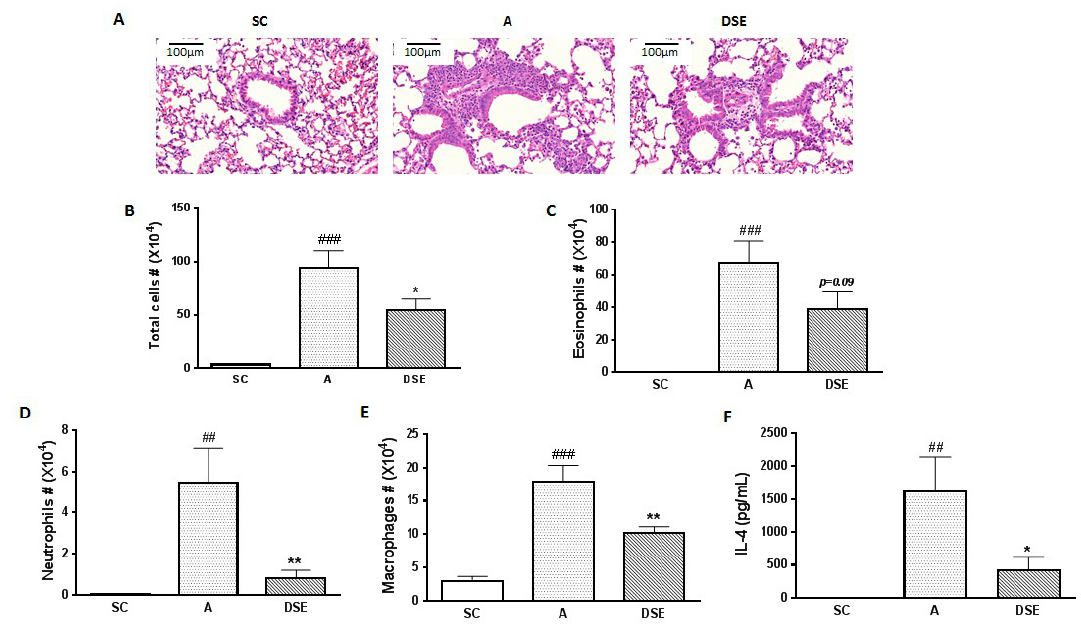
Figure 1. Effects of DSE on phenotypes of allergic asthma in OVA-induced mice. Representative photographs of lung sections stained with H&E (magnification, ×200) ( A ). Counts of: total cells ( B ); eosinophils ( C ); neutrophils ( D ); and macrophages ( E ) in infiltrated BALF. Levels of IL-4 in BALF determined by ELISA ( F ). Data are presented as means ± SEM ( n = 7). ## p < 0.01, ### p < 0.001 compared with the saline control group. * p < 0.05, ** p < 0.01 in allergic lung inflammation vs. vehicle group. SC, Saline Control; A, OVA; DSE, D. sophia seed extract.